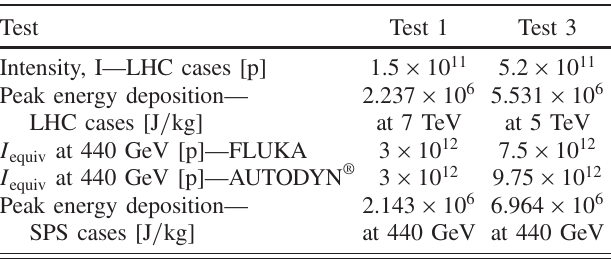
TABLE III. Comparison of the intensity and the peak energy deposition values for the LHC cases and the equivalent SPS cases to be studied. The equivalent intensity ( I based on the equivalent energy peak while I AUTODYN ® is based on the equivalent damage level. The peak energy deposition for the SPS cases is calculated based on I from AUTODYN ® equiv